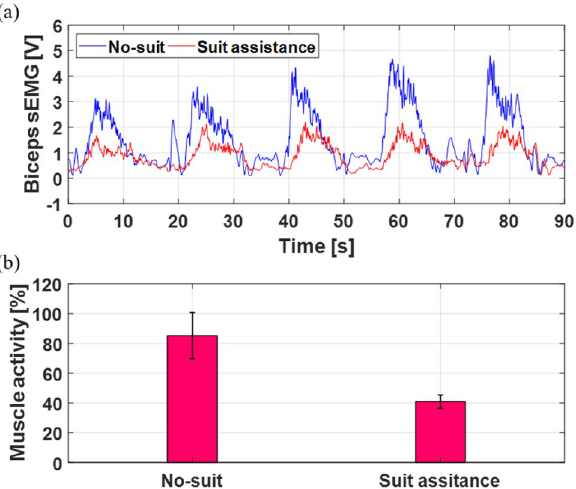
Figure 9. Evaluation of the assistive performance for exosuit. ( a ) Comparison of sEMG signals obtained from the biceps of a representative subject between No-suit and Suit assistance conditions. ( b ) Comparison of muscle activity of subjects between No-suit and Suit assistance